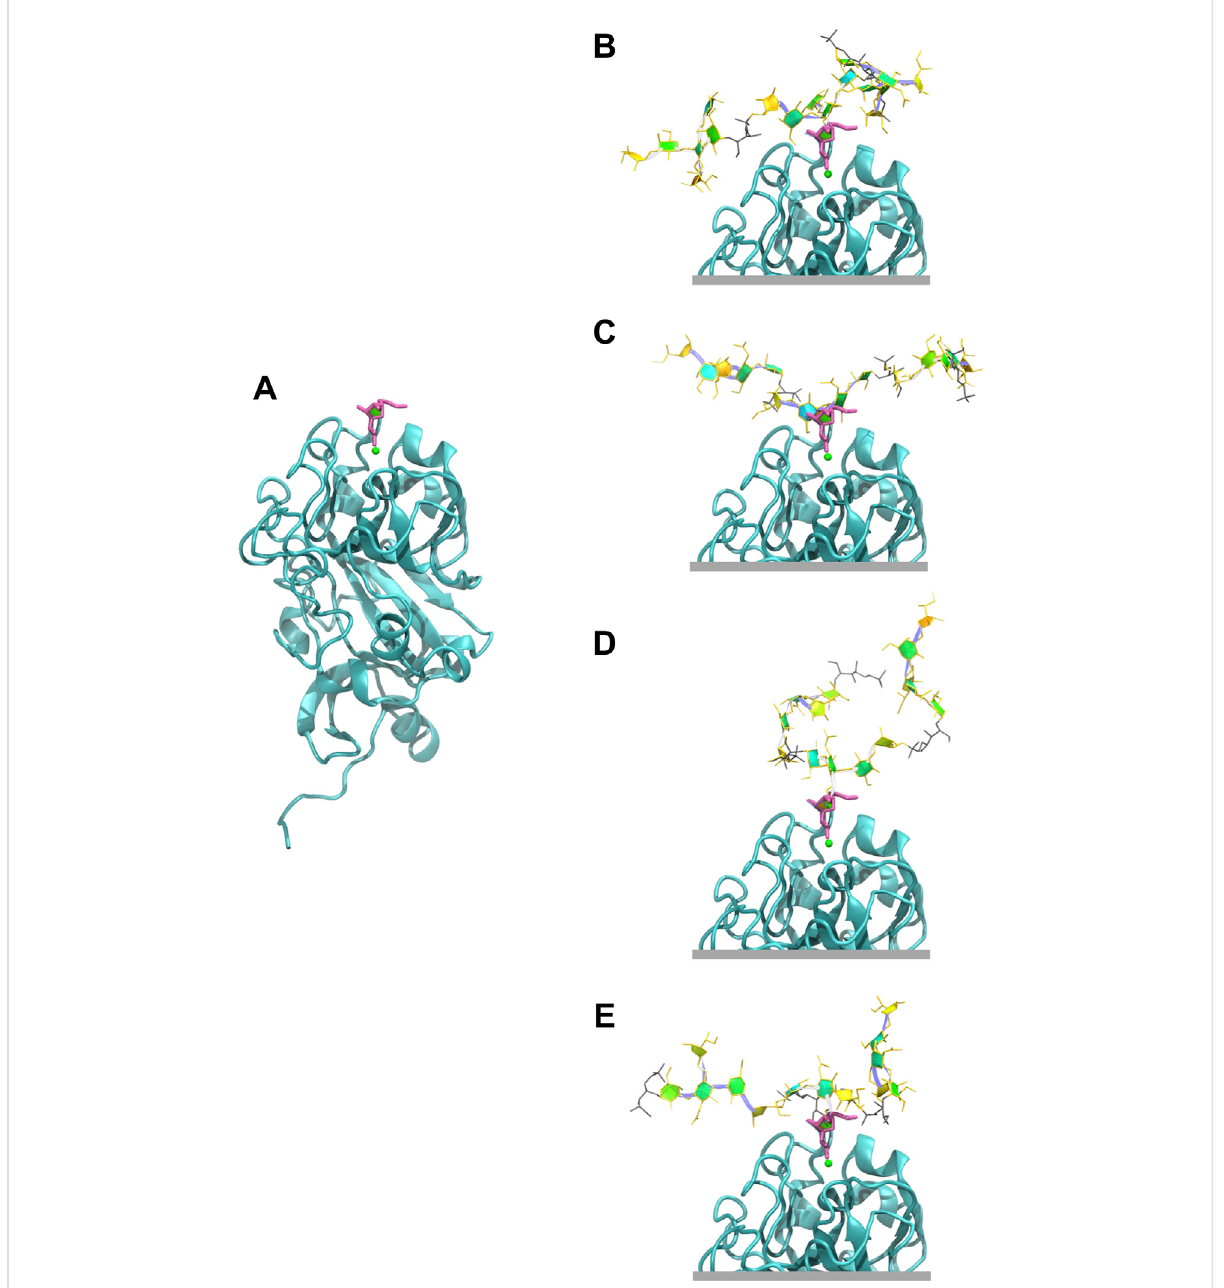
FIGURE 7 Human intelectin-1 (hIntL-1) binding. (A) Monomer of the crystal structure of hIntL-1 bound with allyl-beta-galactofuranose (PDB ID: 4WMY). Example conformations of the 3 RU CPSs with the β DGal f side chain positioned in the hIntL-1 binding site are shown for (B) Pn10A, (C) Pn10B, (D) Pn10C, and (E) Pn10F. The end-to-end distance ( r ) of these conformations are 33 Å, 41 Å, 16 Å, and 33 Å for Pn10A, Pn10B, Pn10C, and Pn10F, respectively. Overlay of our CPS molecules with the hIntL-1 protein binding site were created by aligning the O4, C5, O5, C6, and O6 atoms of the central side group (RU 2) β DGal f residue from each CPS molecule with that of the allyl β DGal f in the hIntL-1 binding site. We then identi fi ed frames where the molecular conformation aligns with the hIntL-1 binding site free from protein-CPS intersection with good alignment of the galactofuranose rings and exocyclic terminal-1,2-diol (ETD)